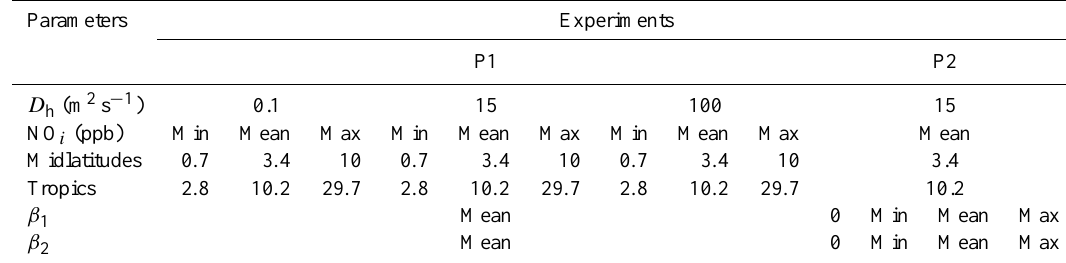
Table 5. Values of the parameters for the plume parameterization corresponding to the experiments P1 and P2. Parameters Experiments